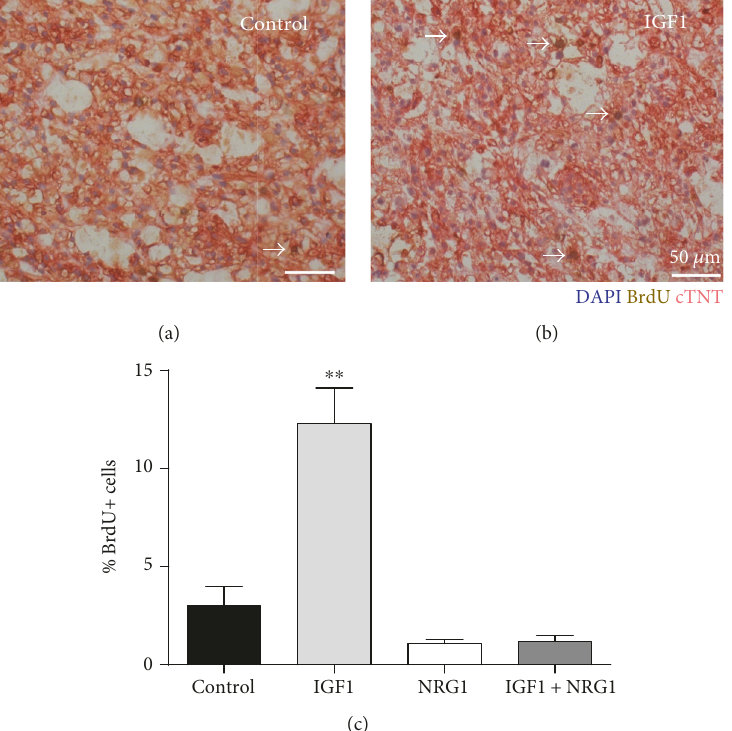
Figure 5: IGF1 stimulates cardiomyocyte proliferation in engineered tissues. Immunohistological staining of cardiac troponin T (pink), nuclei (blue), and bromodeoxyuridine- (BrdU-) positive nuclei (brown) in control (a) and IGF1-treated (b) ECTs. (c) Percent BrdU- positive nuclei was calculated for each group by counting the number of BrdU-positive cardiac nuclei of the total cardiac nuclei ( n = 3 biological replicates with ≥ 100 cardiomyocytes counted per group). ∗∗ P < 0 01 .